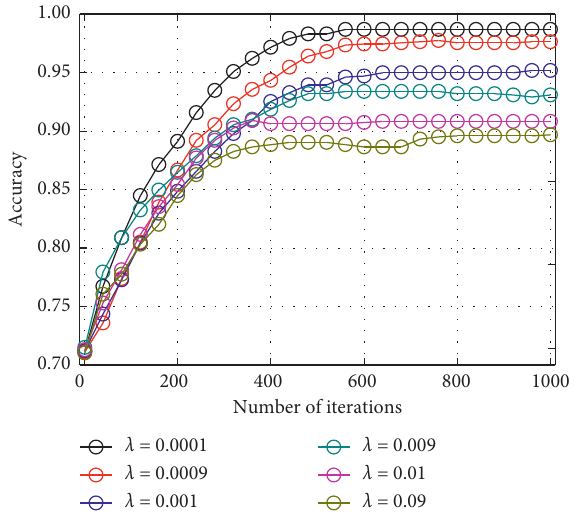
Figure 9: Comparison of recognition accuracy of different at- tenuation coefficients.